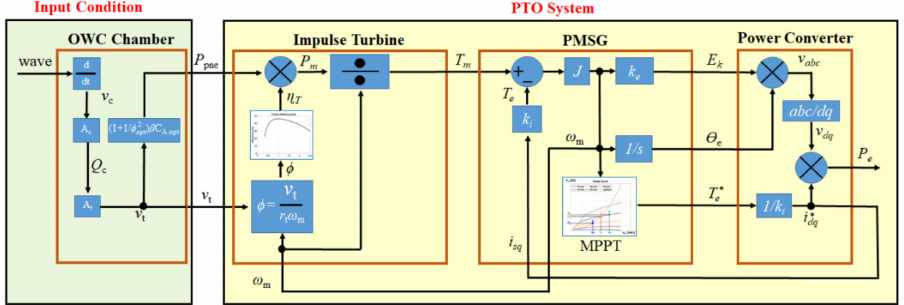
Figure 10. OWC-WEC PTO System integrated simulation configuration